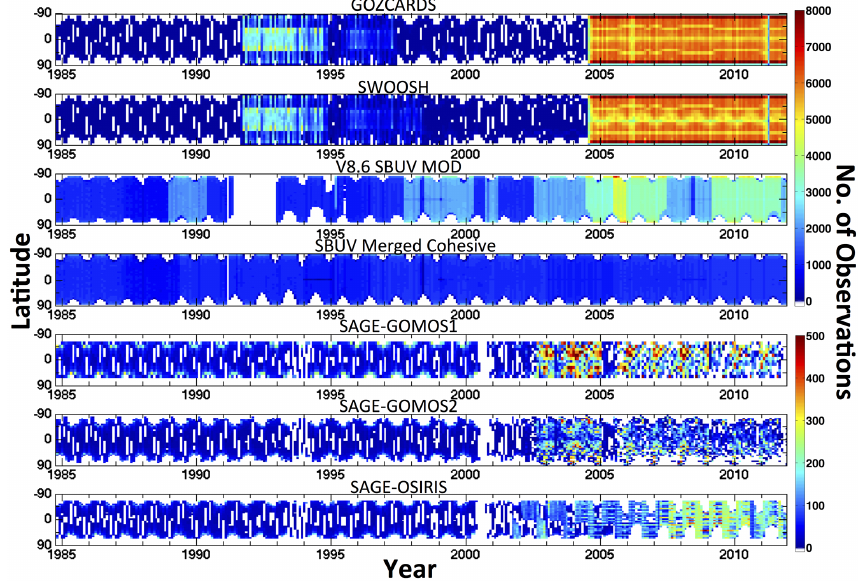
Figure 2. Latitudinal availability of data over the 1984–2011 period. The colours represent the sum of measurements used per latitudinal grid box over the entire profile for each merged data set (note that two separate colour scales are used). Table 3. Summary of the uncertainties provided and individual satellite data sets merged for each of the seven data sets. Data set Uncertainties given with values Data sources merged v8.6 SBUV